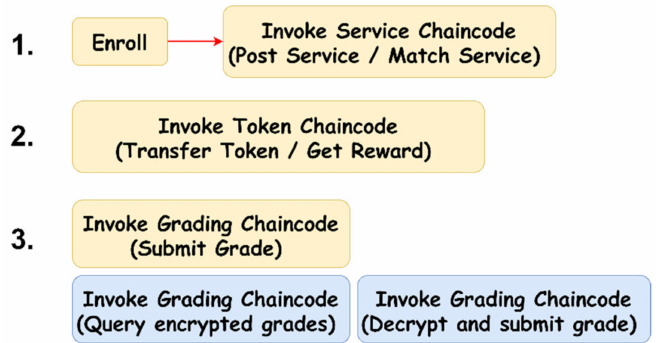
Figure 7. The simplified block diagram of overall operations in the proposed time bank